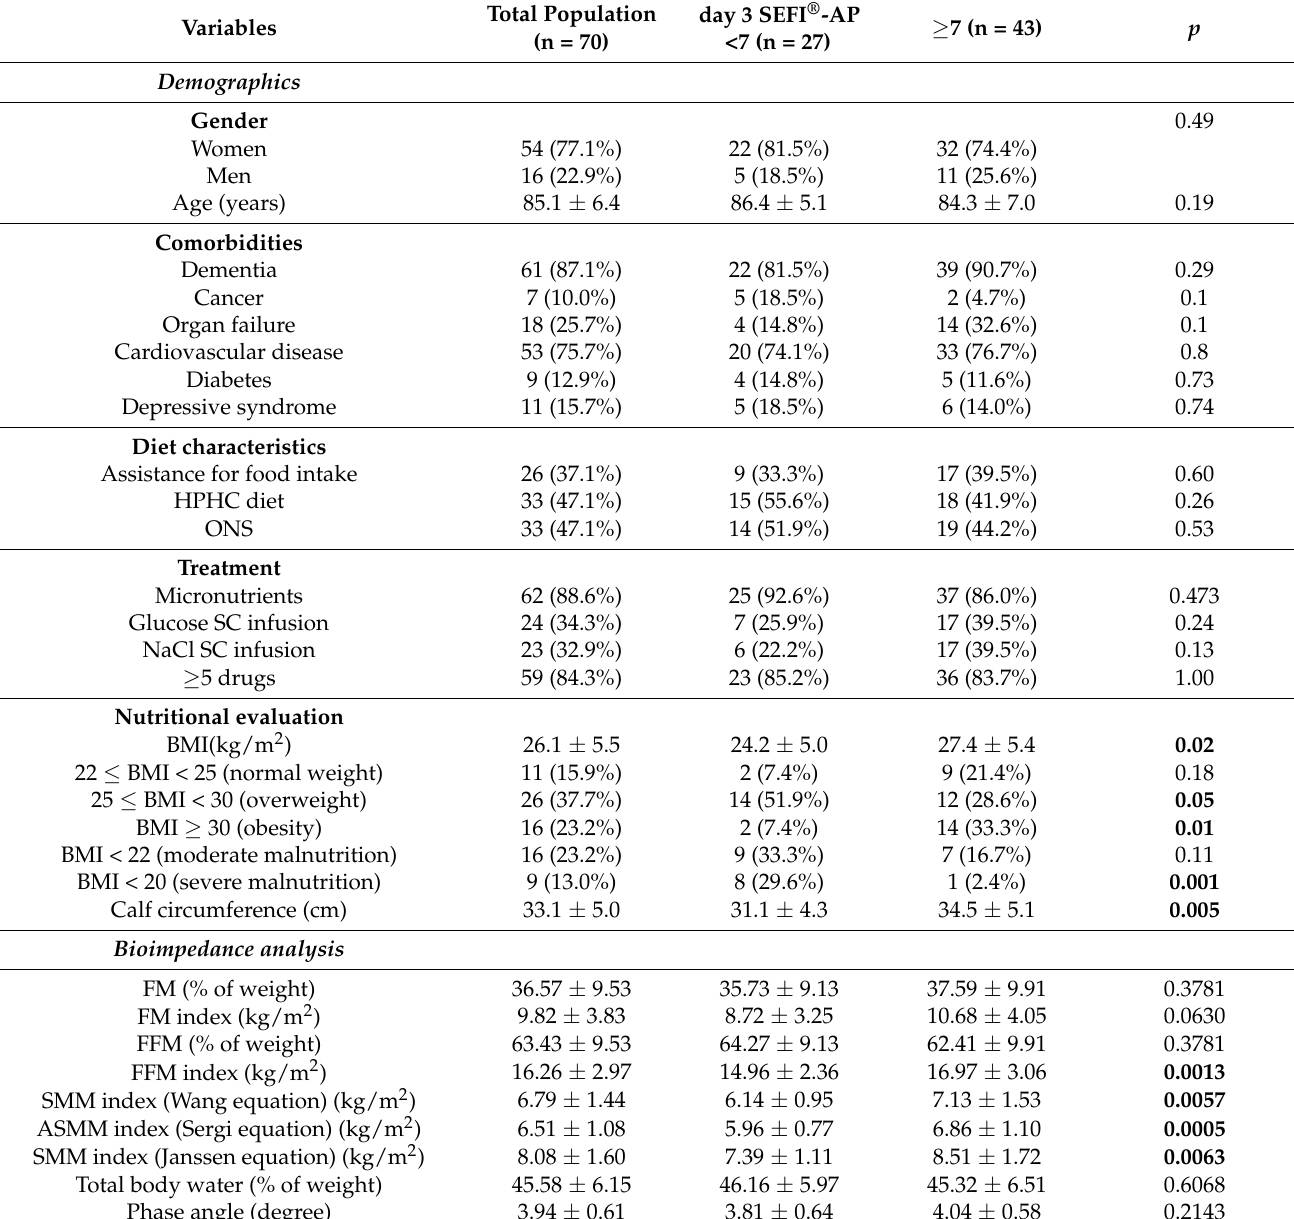
Table 2. Clinical, demographic and nutritional characteristics of the included population (n = 70) according to the levels of food intake at day 3 measured by the Simple Evaluation of Food Intake ® assisted by photography (SEFI ® -AP) (mean of lunch and